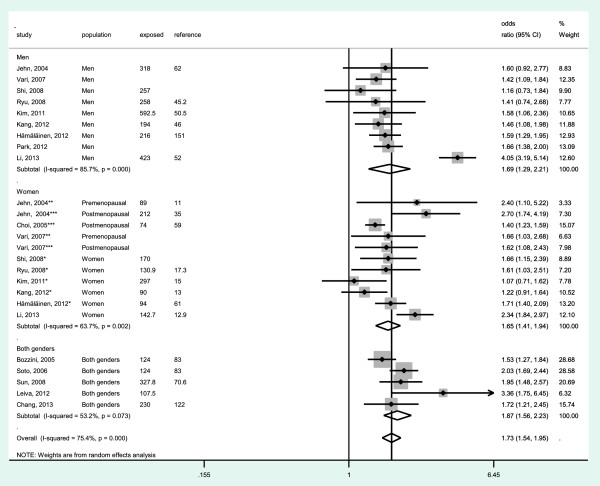
Meta-analysis of the association of ferritin levels with metabolic syndrome in observational studies. Studies are divided by gender (men, women and both genders). Odds ratios correspond to comparisons of extreme categories of exposure within each study. The area of each square is proportional to the inverse of the variance of the log odds ratio. Horizontal lines represent 95% CI. Diamonds represent pooled estimates from inverse-variance weighted random-effects models. NR, not reported.